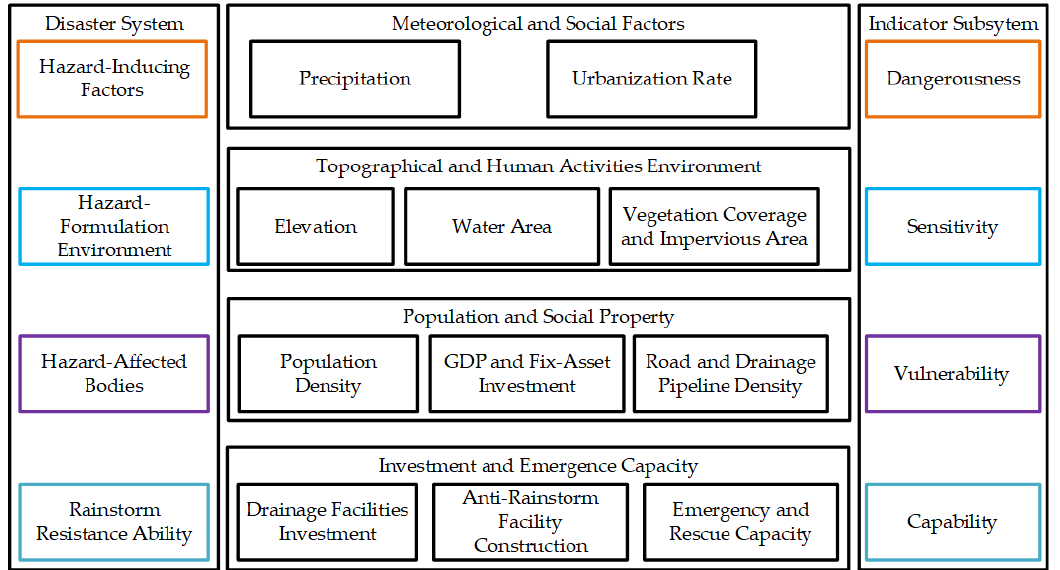
Figure 2. The framework of rainstorm disaster risk assessment based on disaster system theory.